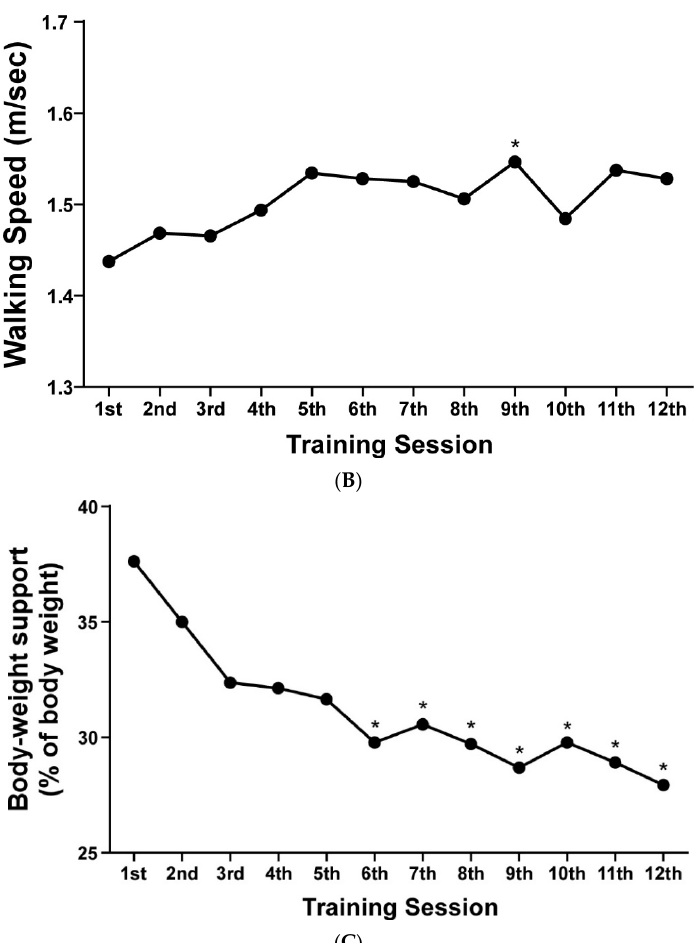
Figure 2. Robot-assisted gait orthosis (RAGO) training parameter trends: ( A ) guidance force; ( B ) walking speed; and ( C ) body-weight support for patients in the RAGO group. * p < 0.05 according to repeated-measures analysis of variance.